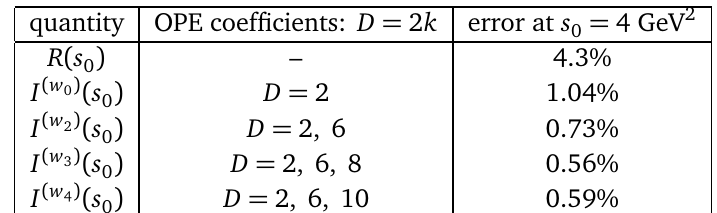
Table 1: R -ratio and moments for the weights I ( w i ) ( s = 4 GeV 2 from the data of Ref. [ 2 ] , with errors propagated from those data, shown s 0 in the third column. The second column shows which terms in the OPE (4) contribute to each of the